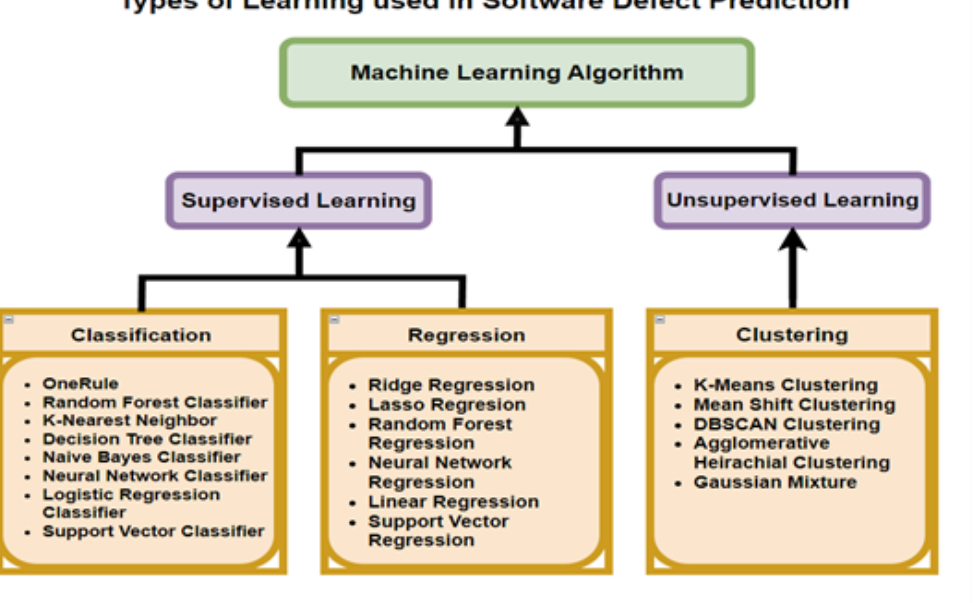
Figure 3. Types of Machine Learning Algorithms used in Software Defect Prediction Kalaivani et al.